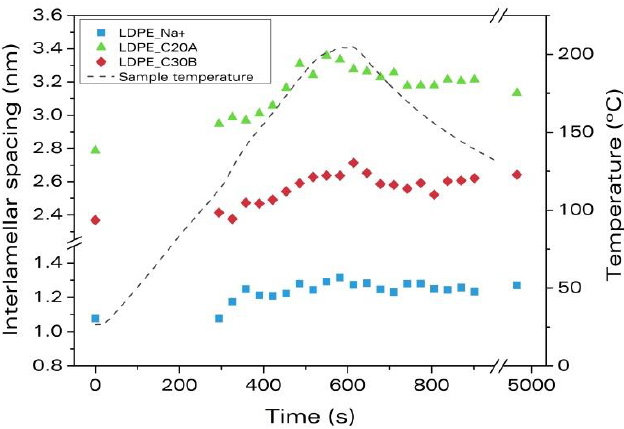
Figure 2. Evolution of the interlamellar spacing of the clay platelets during foaming for the materials based on LDPE.